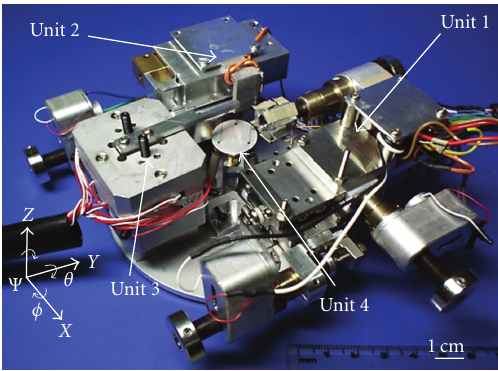
Figure 1: The nanorobotic manipulation system positioned inside the FESEM, containing four units and 16